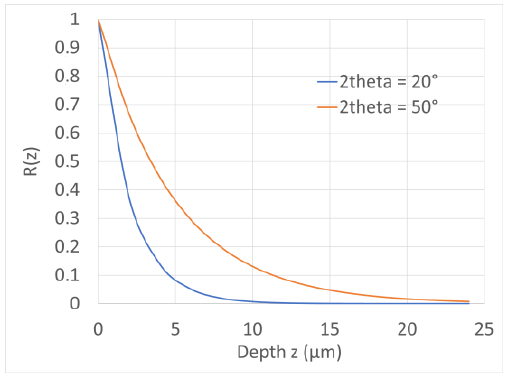
Figure 3. Relative contribution R(z) of emerging radiation for depth > z to intensity diffracted signal for the studied glass-ceramics.